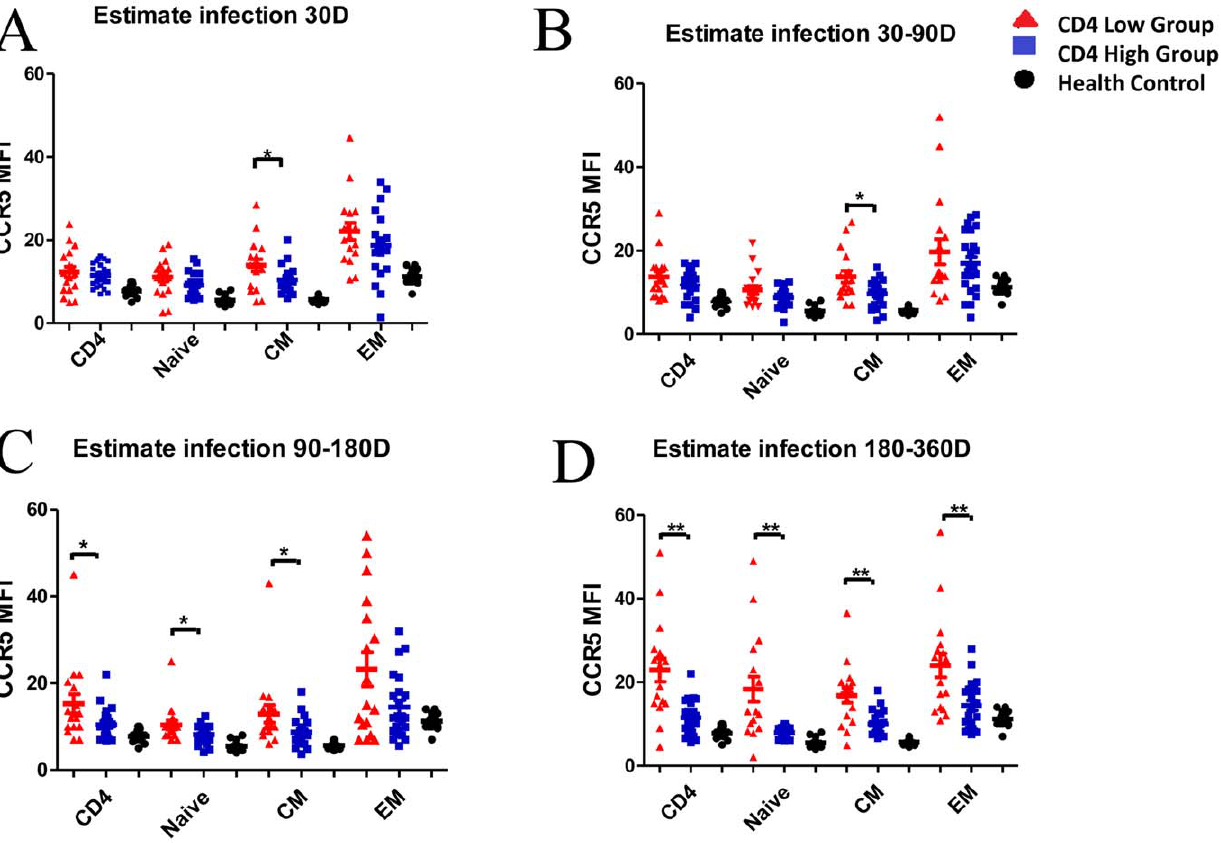
Figure 2. Comparison of the median fluorescence intensity (MFI) of CCR5 on CD4 subsets between the CD4 High and CD4 Low groups. Comparison of the median fluorescence intensity (MFI) of CCR5 on CD4 subsets between the CD4 High and CD4 Low groups among estimated infection 30day(A), 30–90 day(B), 90–180day(C), 180–360day(D). **p , 0.01, *p , 0.05.